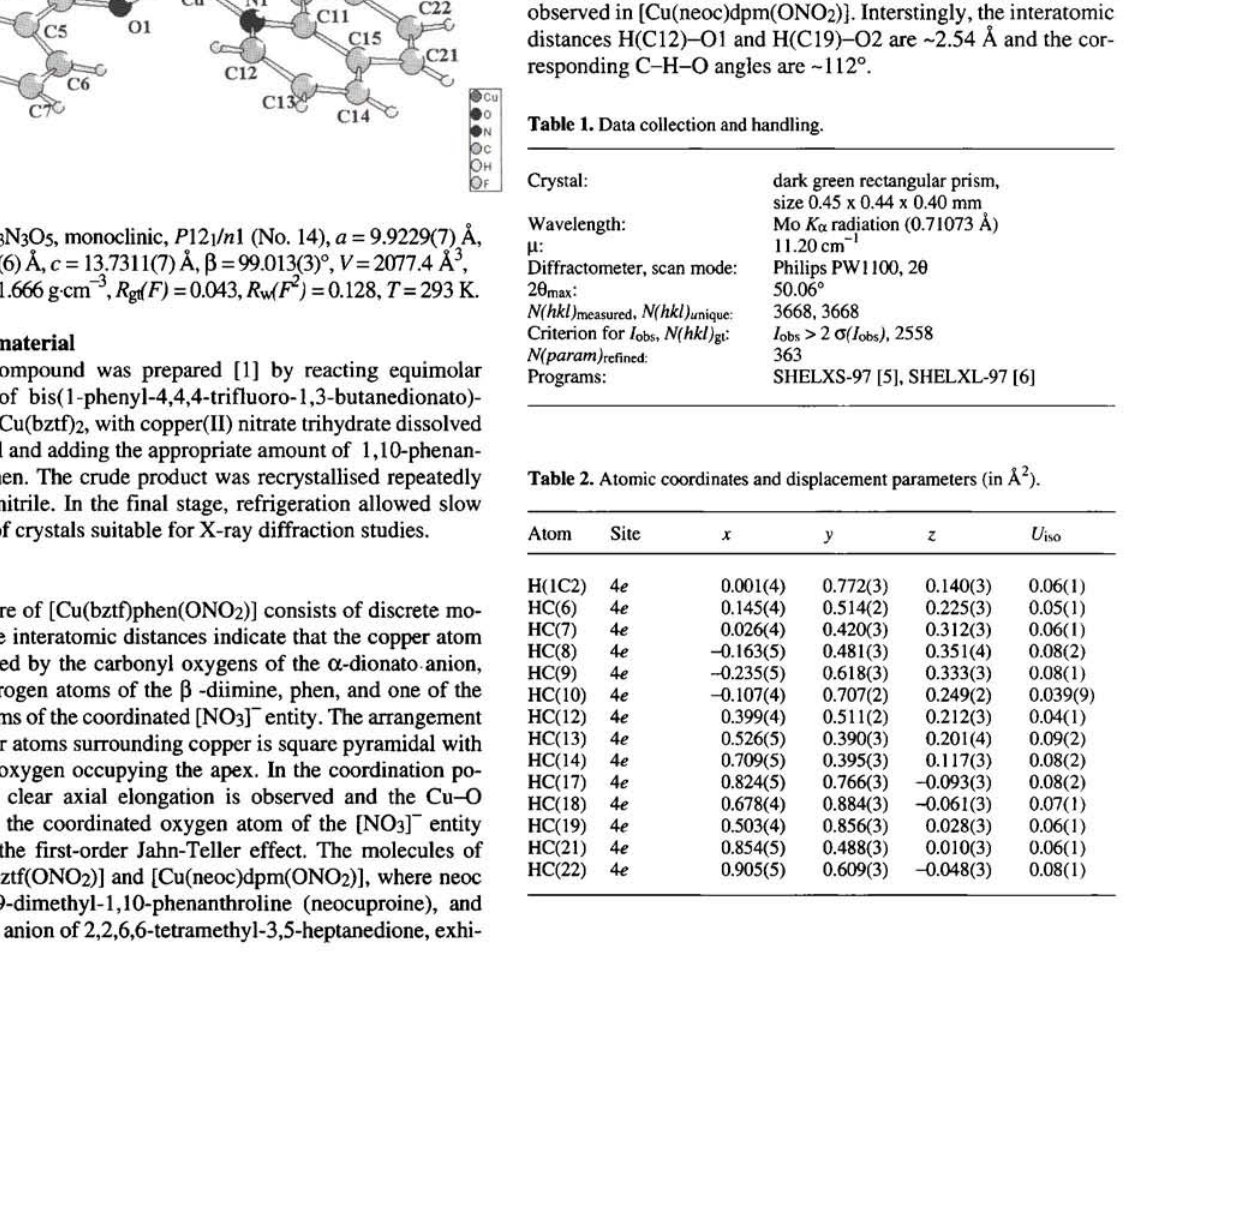
Table 1. Data collection and handling.